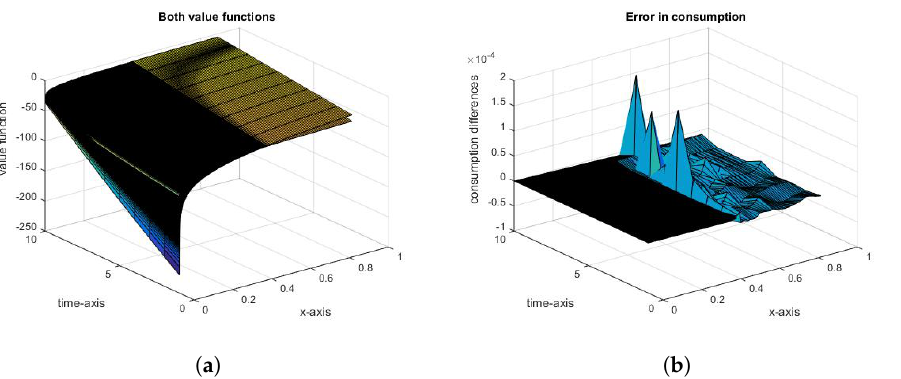
Figure 1. (In-)accuracy of the value function versus the accuracy of the optimal control. ( a ): Numerical and actual value functions, V S ( t , x ) , for the social optimum; ( b ): The error in c S ( t , x ) (the difference between numerical and actual values) for the social